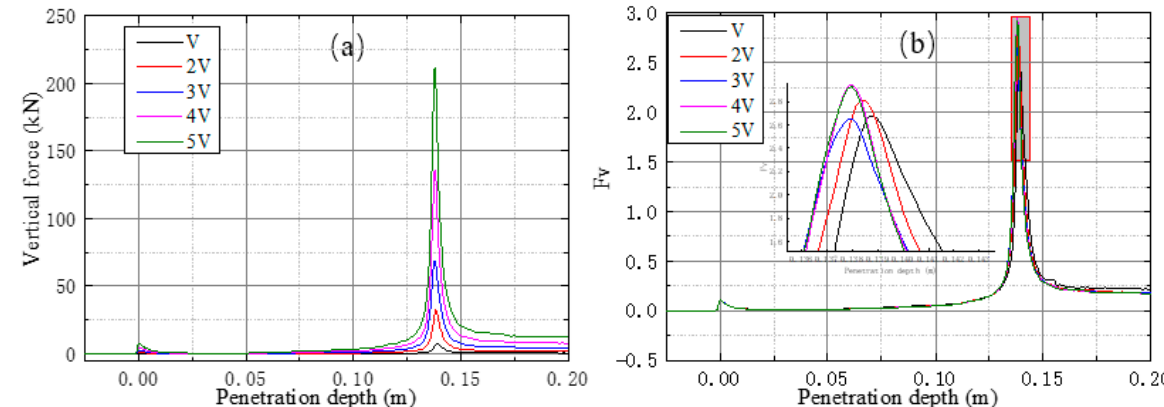
Figure 9. The vertical force varying the penetration depth for different constant entry velocity and F v estimated from these CFD results (( a ) Vertical forces against penetration depth under five velocities; ( b ) The separated drag coefficient F v ).